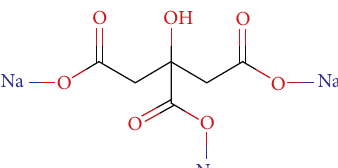
Figure 1: Structural formula of sodium